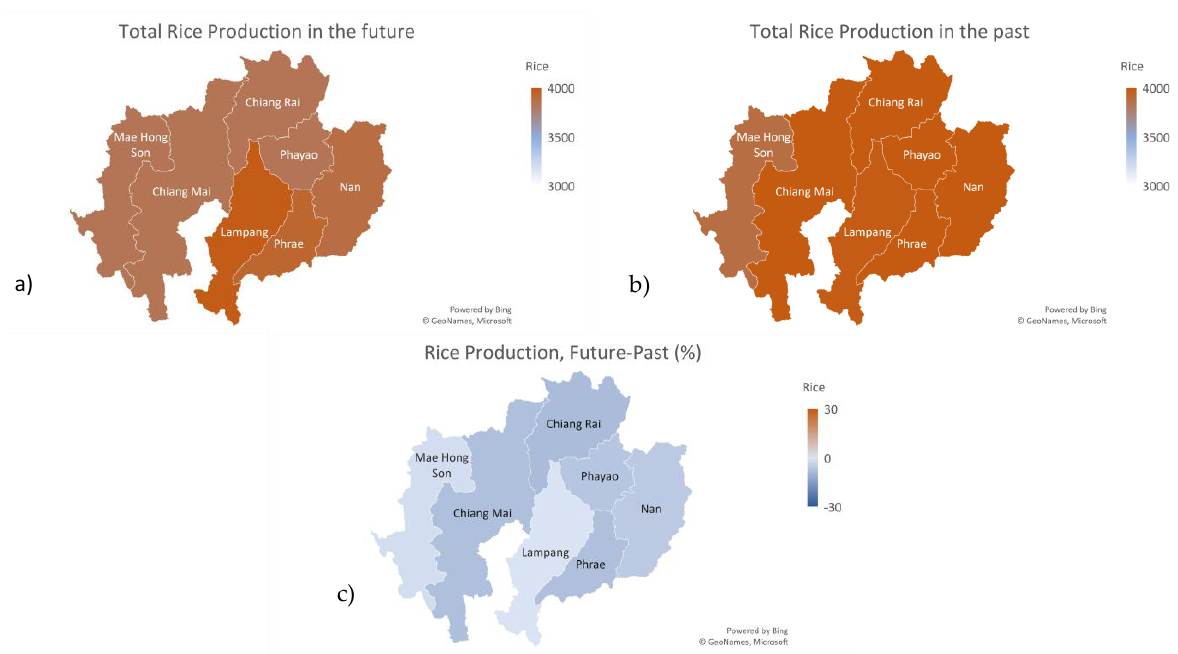
Figure 4. Average rice production in the wet season in ( a ) 2020–2029 and ( b ) 2010–2018, and ( c ) the difference between 2020–2029 and 2010–2018.